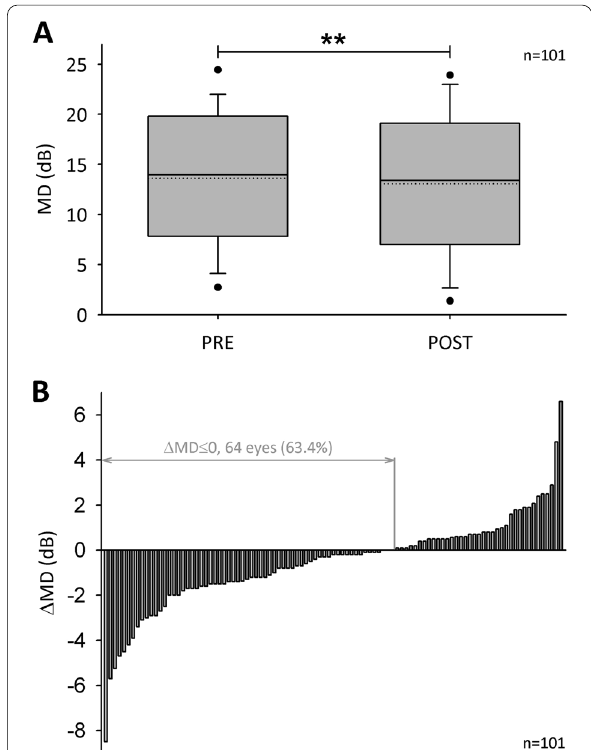
Fig. 1 A Boxplots of PRE and POST mean defect (MD) in 101 eyes of 70 patients. Mean is given as dotted line. Black dots mark 5th and 95th percentiles. Asterisks indicate statistically significant reduction as analyzed by Wilcoxon signed rank test ( p < 0.01). B Changes of MD in all 101 eyes as calculated by subtraction of PRE value from POST value (ΔMD). In 64 eyes of 49 patients (63.4%) ΔMD was 0 or